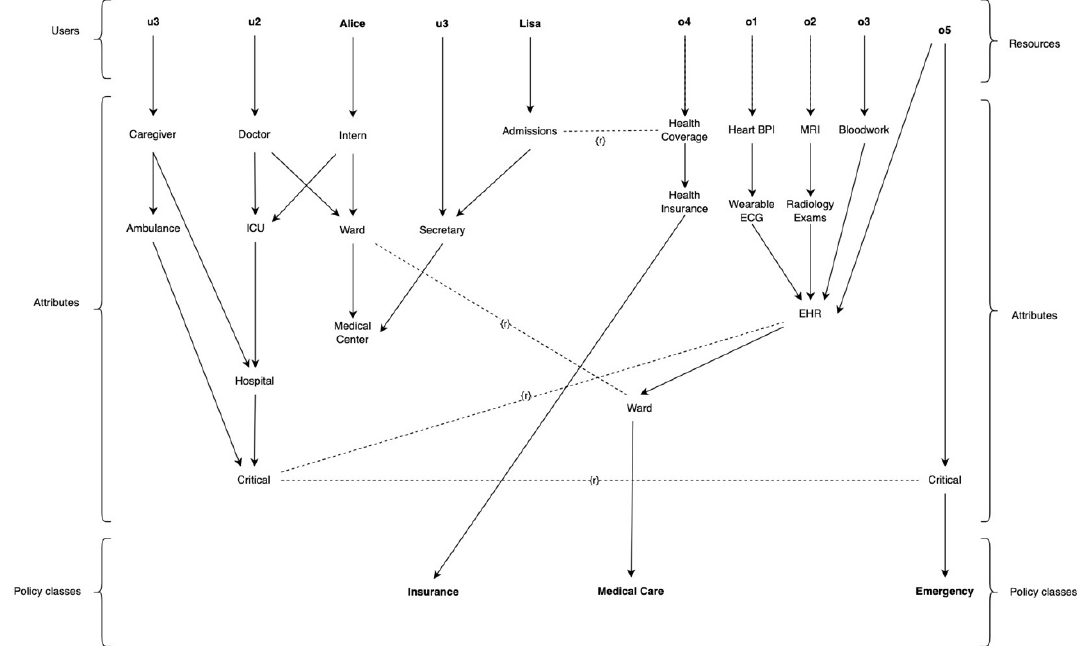
Figure 7. NGAC policy snapshot.